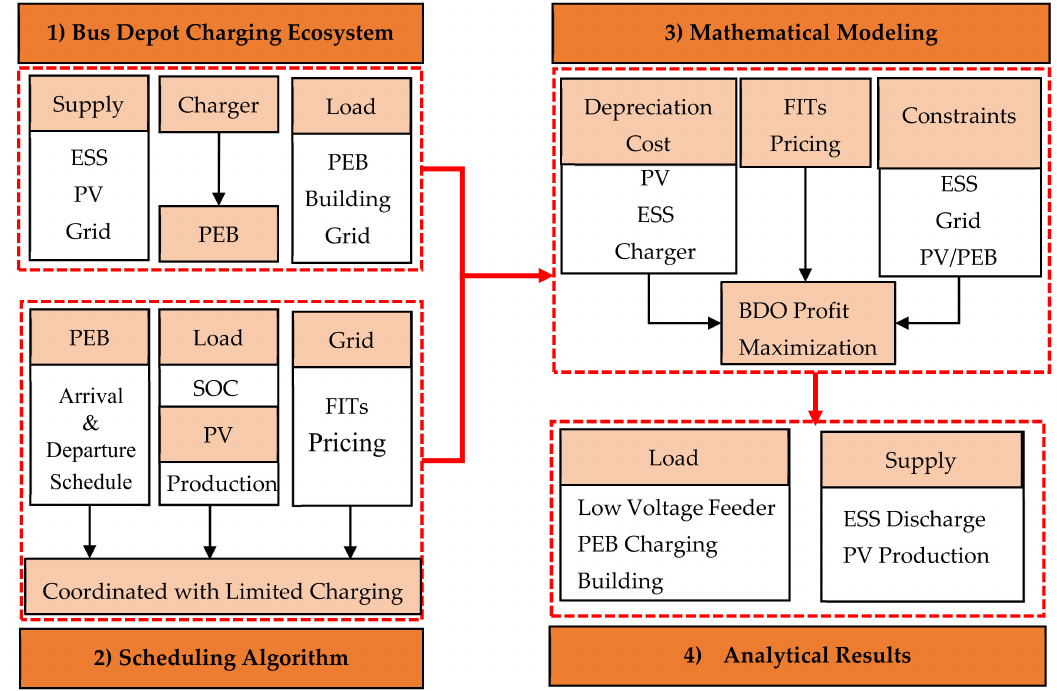
Figure 1. A framework of the proposed